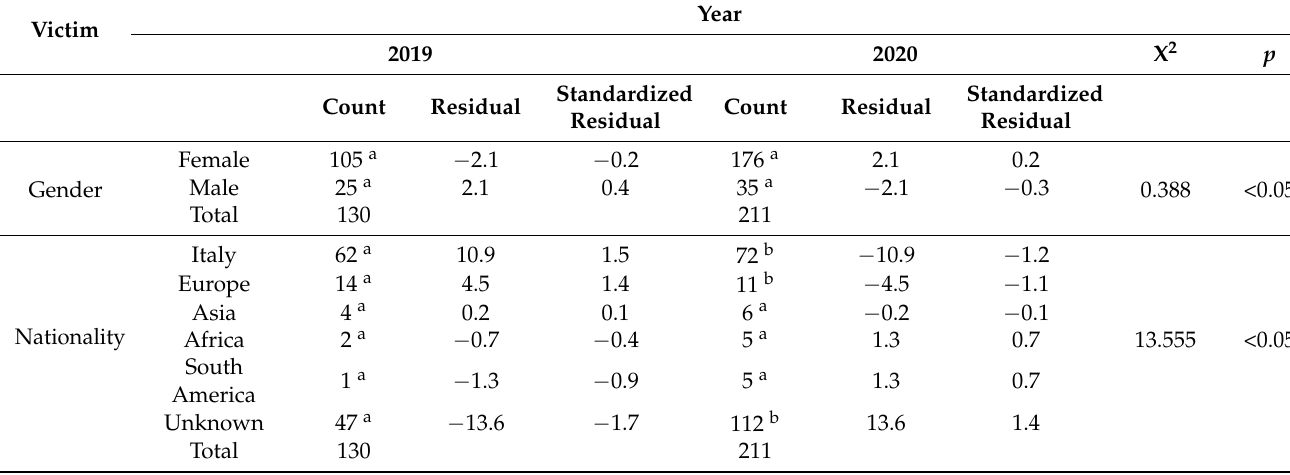
Table 2. Information about the victims by years.